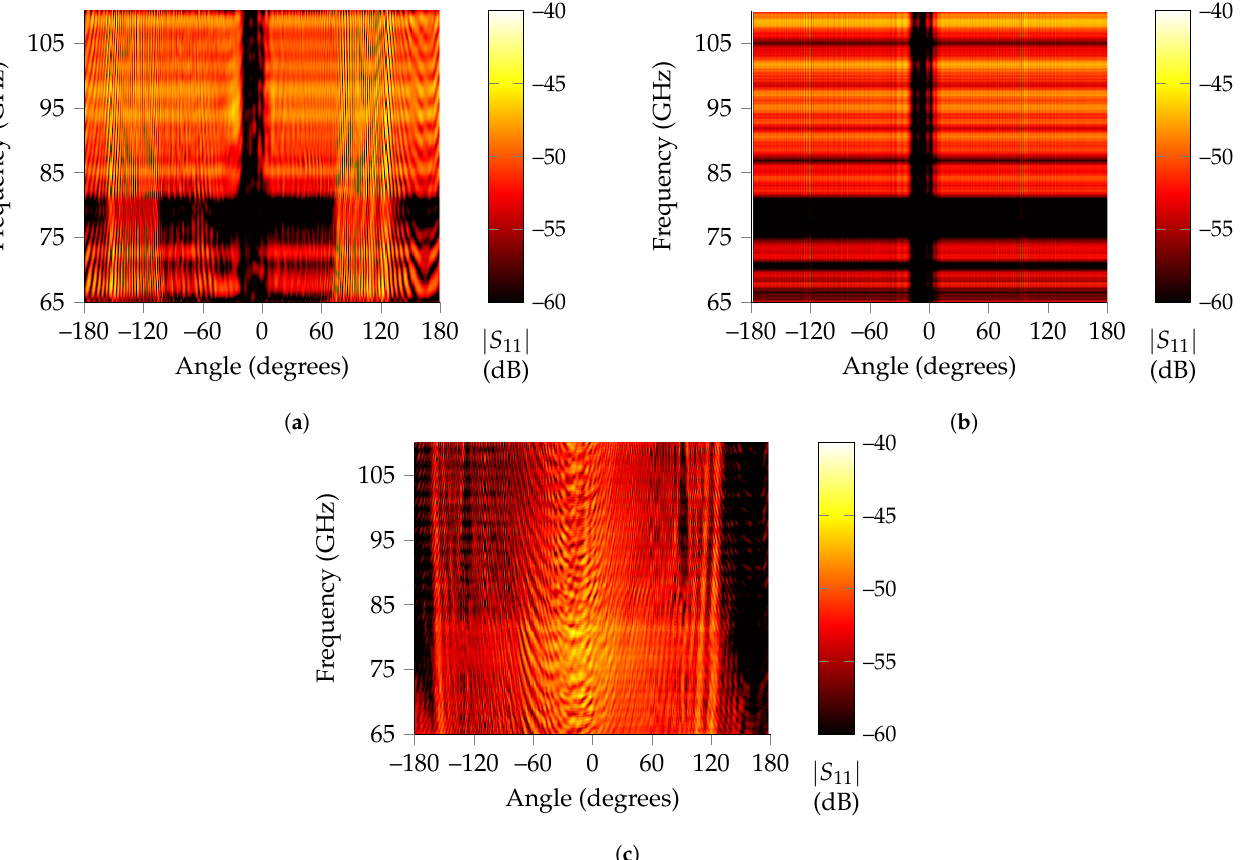
Figure 6. Received power in terms of angle and frequency when a small metallic rod rotates around the low-Q tag. ( a ) Time- gating results for all angles. The two received high-amplitude regions on the sides, owing to the rod encroaching on the time-gated span, and the deep notch region on the center due to blockage are easily noticeable. ( b ) RPCA extracted tag responses for all rotations. Only the low received amplitude region remains. ( c ) Clutter extracted by RPCA. It is noticeable the high amplitude response around blockage area (Approx. from –30 ◦ to 0 ◦